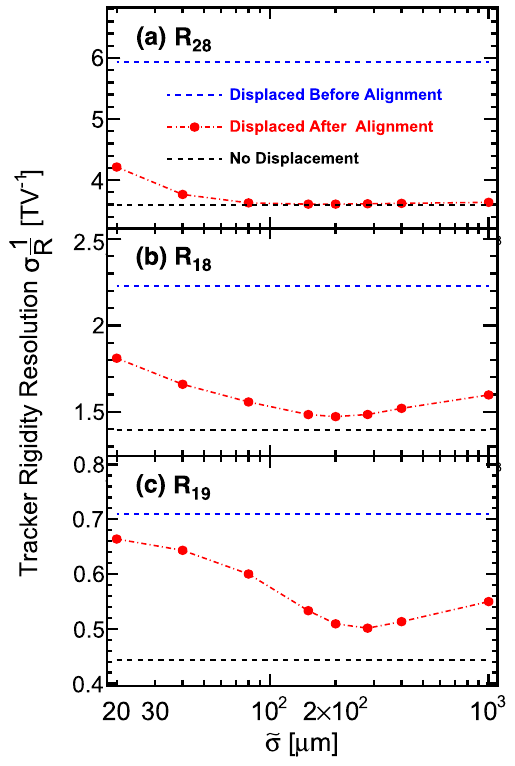
Fig. 20 The proton rigidity resolutions σ( 1 / R ) of a the inner tracker ( R = R ), b L1 and the inner tracker ( R = R ), and c the full-span 28 18 tracker ( R = R 19 ) at 1.5 TV as functions of the curvature constraint (cid:23) σ, obtained from the alignment on the MC with the tracker modules dis- placed (full circles and dot-dashed curves). The rigidity resolutions for no module displacement (dashed lines) and displaced modules before alignment (solid lines) are also